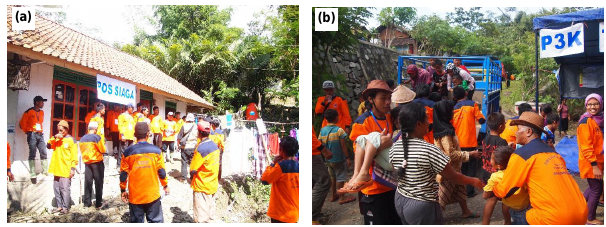
Figure 6: Evacuation drill process: (a) coordination among the disaster preparedness and response team; (b) evacuation to the 5 temporary shelter. Figure 6. Evacuation drill process: (a) coordination among the dis- aster preparedness and response team; (b) evacuation to the tempo- rary